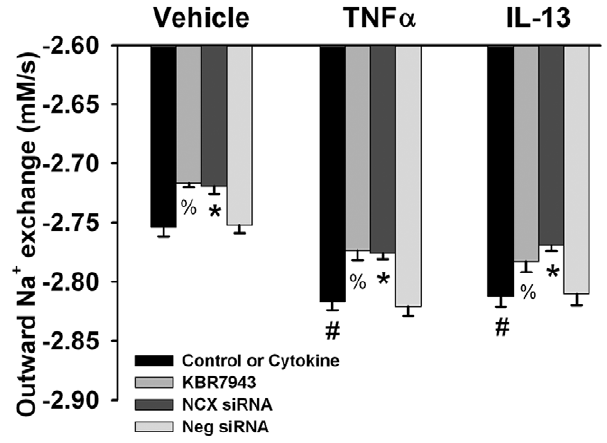
Figure 6. Effect of pro-inflammatory cytokines on Na + outward exchange via NCX in human ASM. In SBFI loaded ASM cells where inward exchange-mode NCX was evaluated using the protocol illustrated in Figure 3, TNF a or IL-13 significantly enhanced Na + outward exchange compared to controls not exposed to cytokines. KBR7943 and NCX1 siRNA (but not negative siRNA) both significantly inhibited outward Na + exchange and blunted cytokine effects. Vehicle is culture media, HBSS, or Lipofectamine as appropriate. Values are means 6 SE (n=5 patient samples for controls, 3 patient samples for cytokine groups; minimum 50 cells per bar). % indicates significant KBR7943 effect, * significant NCX1 siRNA effect, and # significant cytokine effect (p , 0.05).